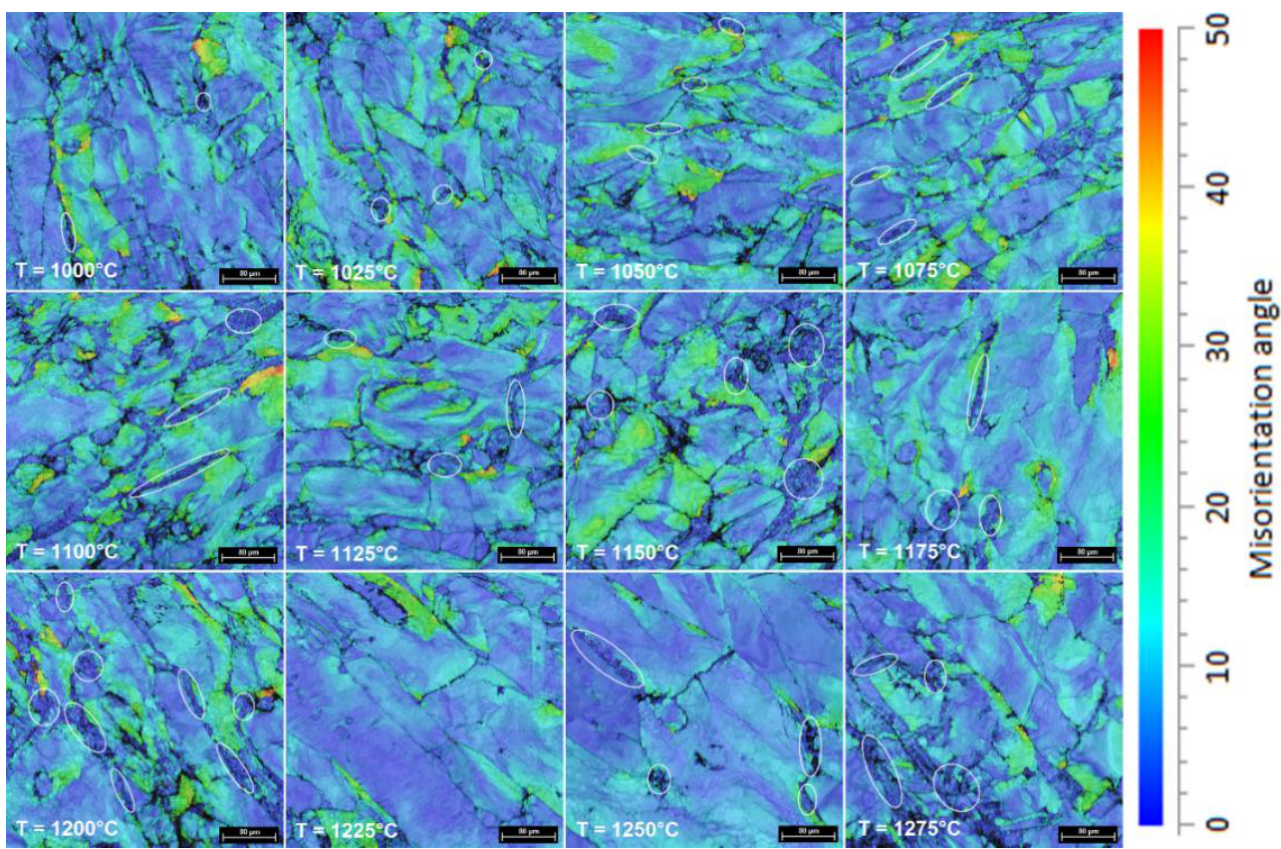
Figure 6. Typical GROD distribution maps, for both γ-phase and δ-phase, in hot-deformed UNS S32750 SDSS alloy (from 1000 °C to 1275 °C).